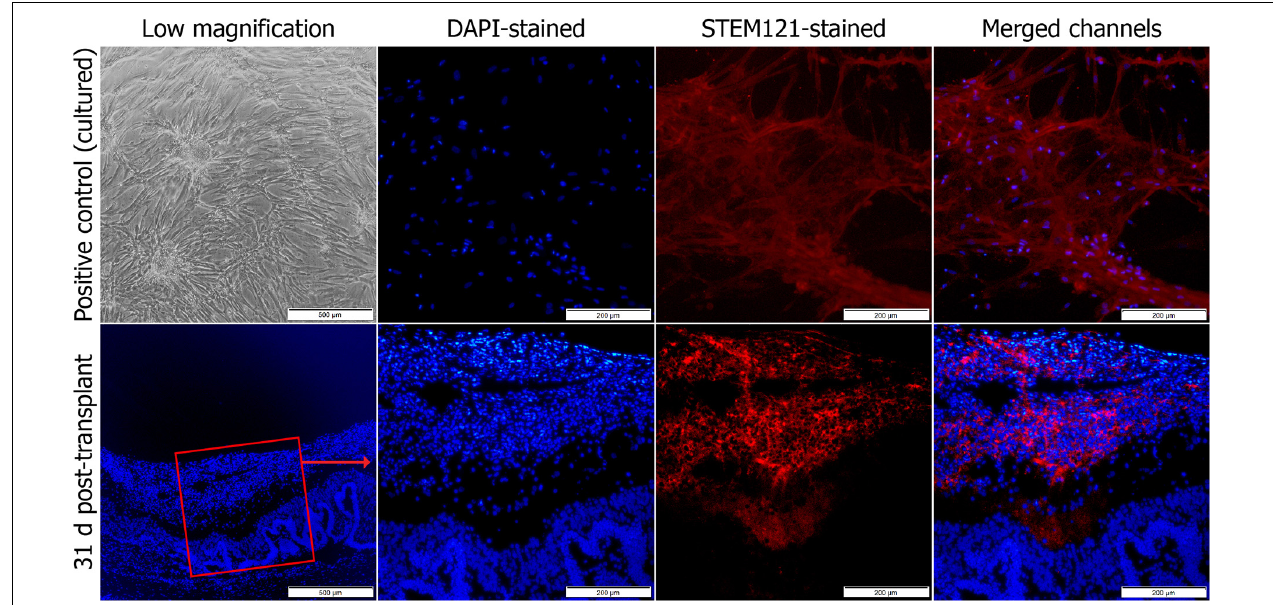
FIGURE 2 | Immunohistochemical staining of transplanted MSCs EPO in the retinal degeneration model. The stem cells were stained with human STEM121 antibodies (red signal), while DAPI (blue) was used as a nuclear counterstain. This was performed at the end of the study. After 30 days, the cells had engrafted onto the retina with no signs of penetration into the inner layers. Stained MSCs EPO in culture was used as a positive control. The sections were viewed under 40 × (low) and 100 × total magnification. The scale bars were denoted as 500 and 200 µ m, respectively.